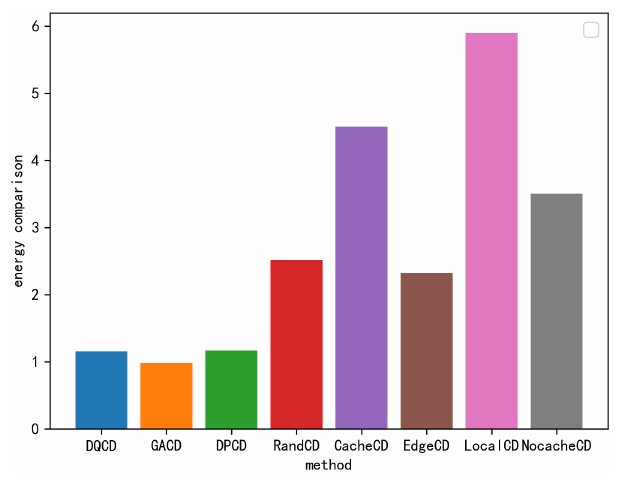
Figure 3. Energy consumption comparison.